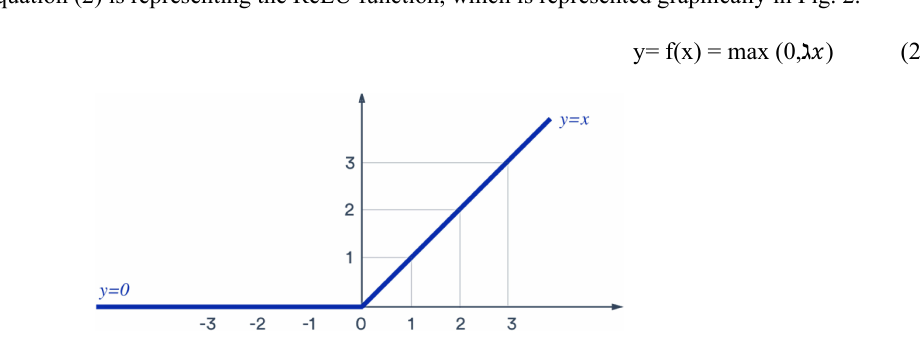
Fig. 2 Graphical representation of ReLU function which is expressed in equation [27]